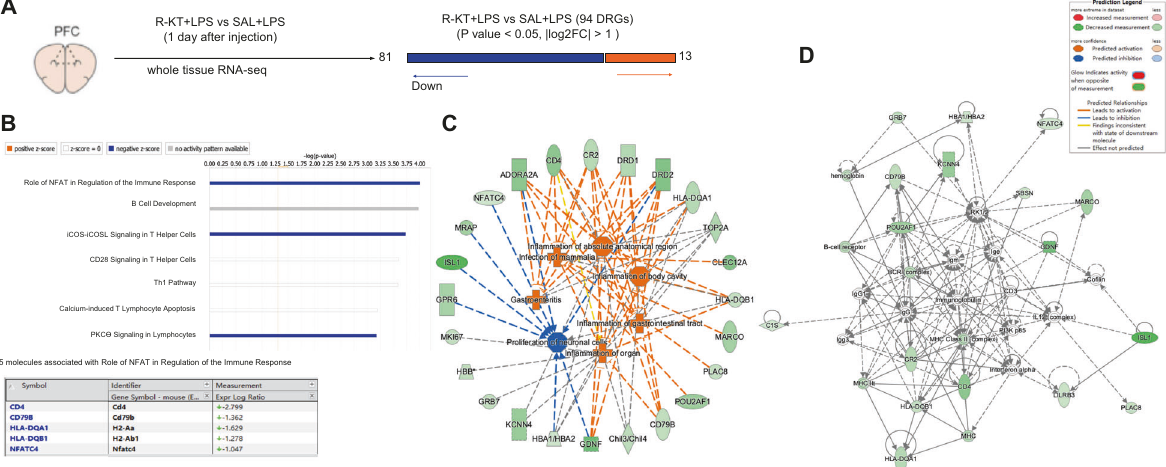
Fig. 2 Canonical pathway, protein functional network and diseases analysis for differentially genes in the PFC after LPS injection. A Adult mice were i.p. injected with LPS (1.0 mg/kg) 6 days after i.p. administration of ( R )-ketamine (10 mg/kg) or saline (10 ml/kg). For RNA- sequencing, PFC samples were collected 24 h after injection of LPS. B Top 7 canonical pathways altered in the PFC were identi fi ed by Ingenuity Pathway Analysis (IPA). The role of NFAT in regulation of the immune response signaling pathway had the highest inhibition scores ( P = 9.85E − 05, z-score = – 2.236). C IPA constructs identi fi ed relationships between the differentially expressed genes and associated disorders. D The most signi fi cant molecular network by IPA pathway enrichment analysis. IPA Z-score indicates whether the pathway is predicated to be inhibited (blue) or activated (red). In some cases, activation or inhibition cannot be predicated (gray). The shapes of the proteins imply their molecular classes as outlined in the legend. Solid lines indicate direct interaction whereas dashed line correspond to indirect relationship among the interacting proteins. The arrows indicate modulatory effect of a protein on its interacting